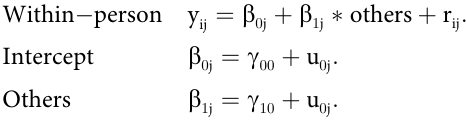
(others in the model below). Intervals were nested within participants, and perceptions of oth- ers were entered group mean-centered. The model is presented below, and the results of these analyses are summarized in Table 5.